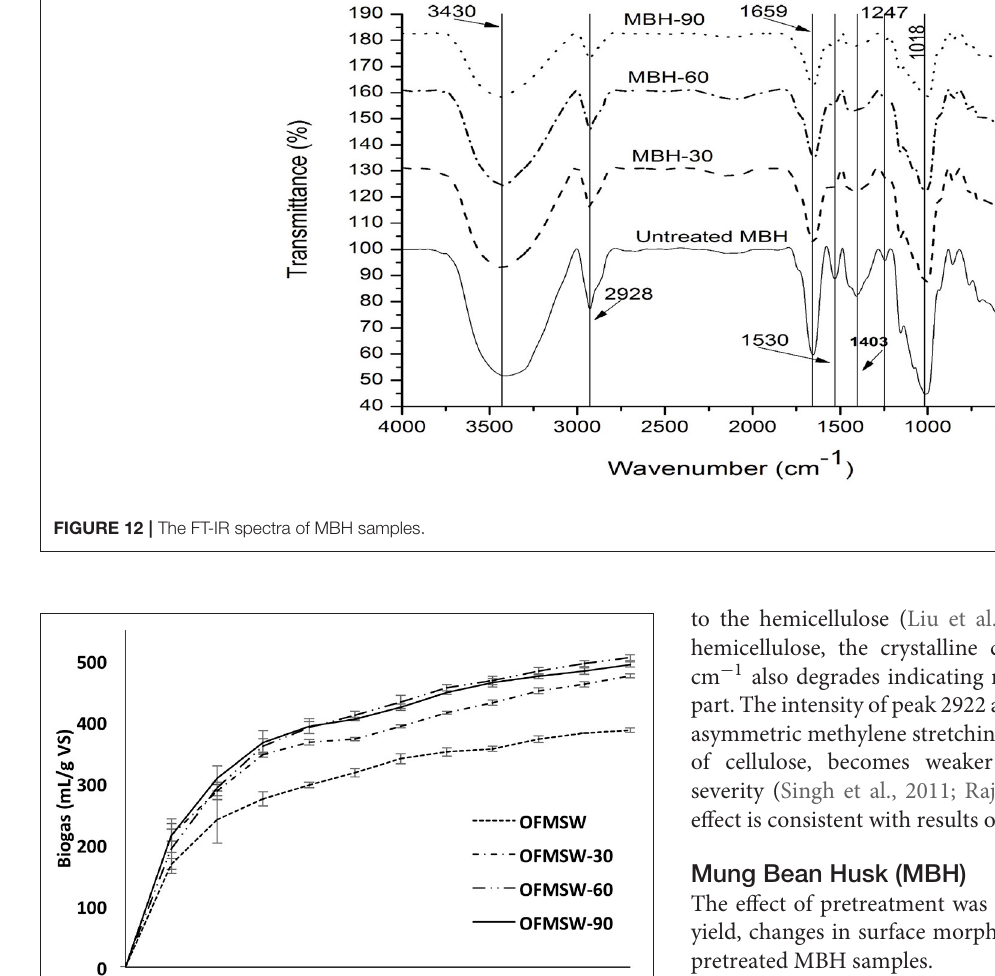
hemicellulose, and cellulose structure i.e., in a